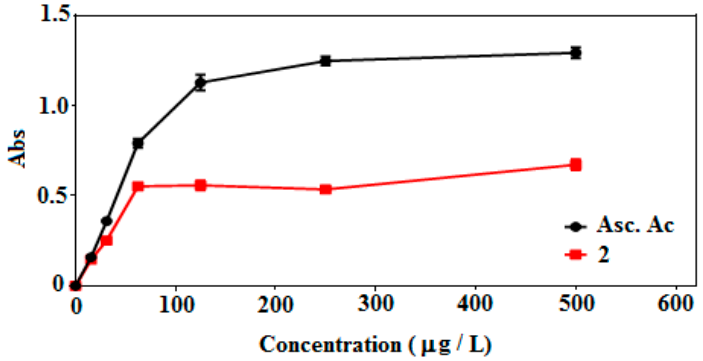
Figure 9. Reducing power activity of compound 2 .